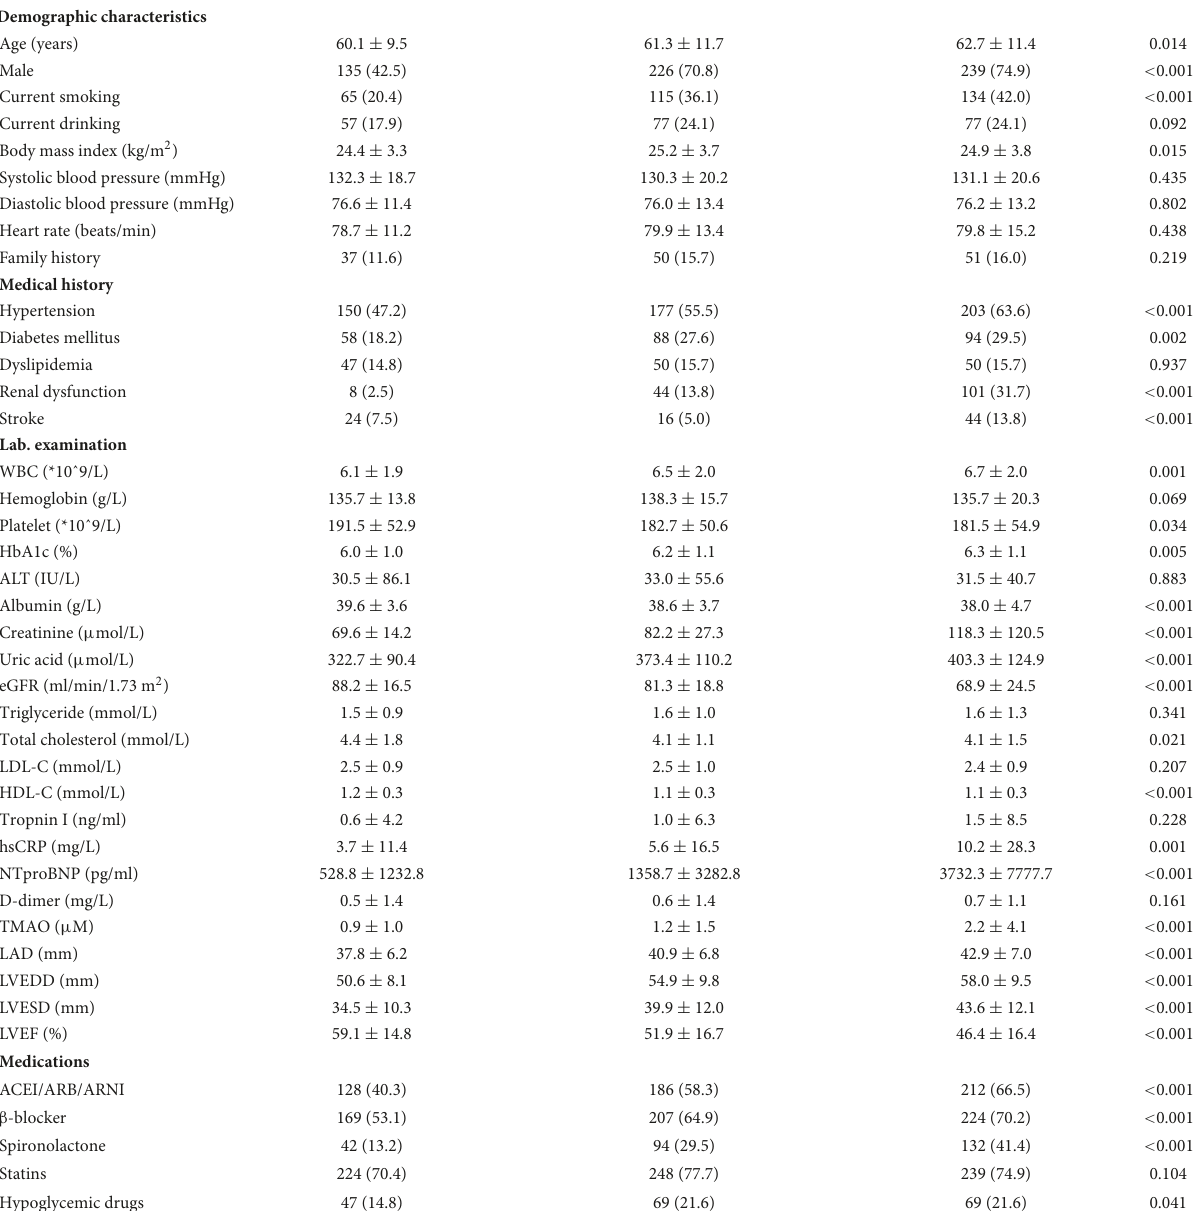
TABLE 1 Baseline characteristics of all